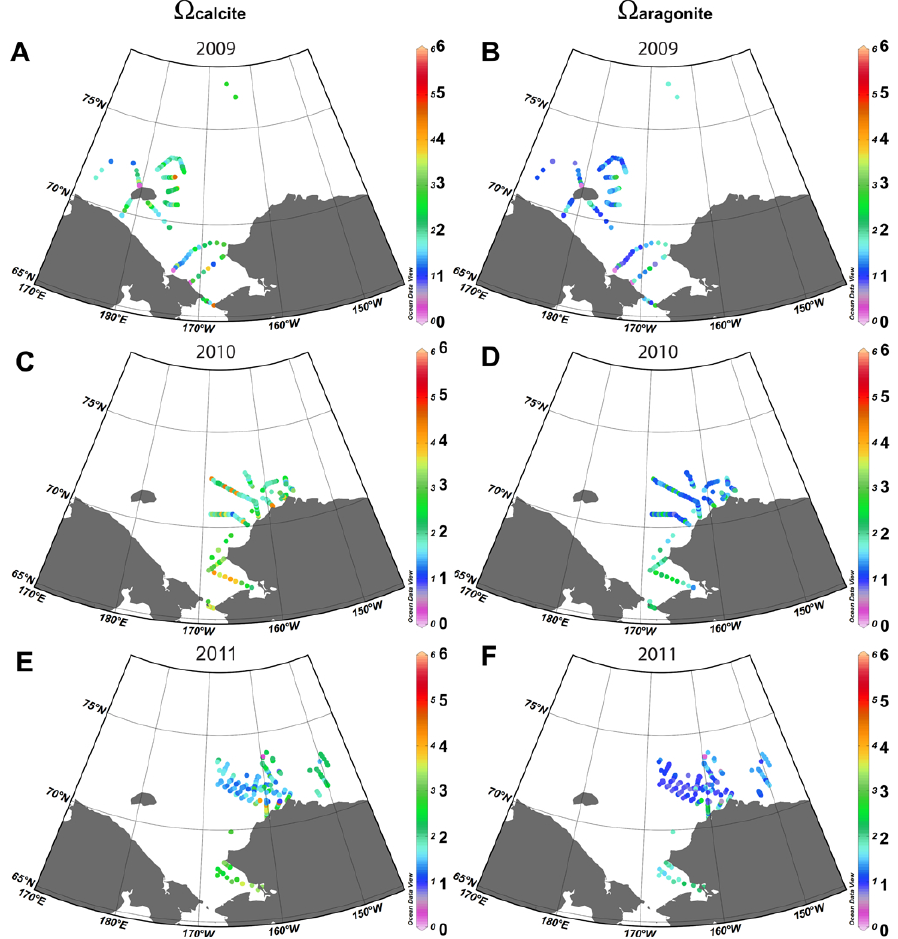
Fig. 7. Summertime maps of bottom-water (cid:127) calcite and (cid:127) aragonite for individual years in 2009, 2010 and 2011 in the western Arctic Ocean (primarily Chukchi Sea but also eastern East Siberian Sea and western Beaufort Sea). (cid:127) calcite data are plotted in panels (A) , (C) and (E) , while (cid:127) aragonite data are plotted in (B) , (D) and ( F